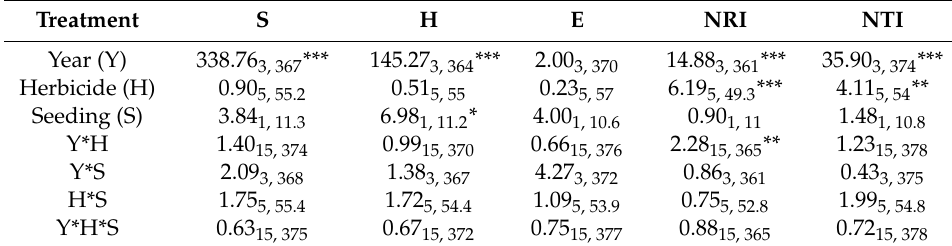
Table 1. F-statistics degrees of freedom , and p -values (* < 0.05, ** < 0.01, *** < 0.001) from mixed model repeated measures tests on the e ff ects of herbicide and seed addition treatments and their interactions through time (years) on taxonomic (S = richness, H’ = Shannon’s diversity, and E = evenness) and phylogenetic diversity (NRI: net relatedness index, NTI: nearest taxon index) across three prairie restoration